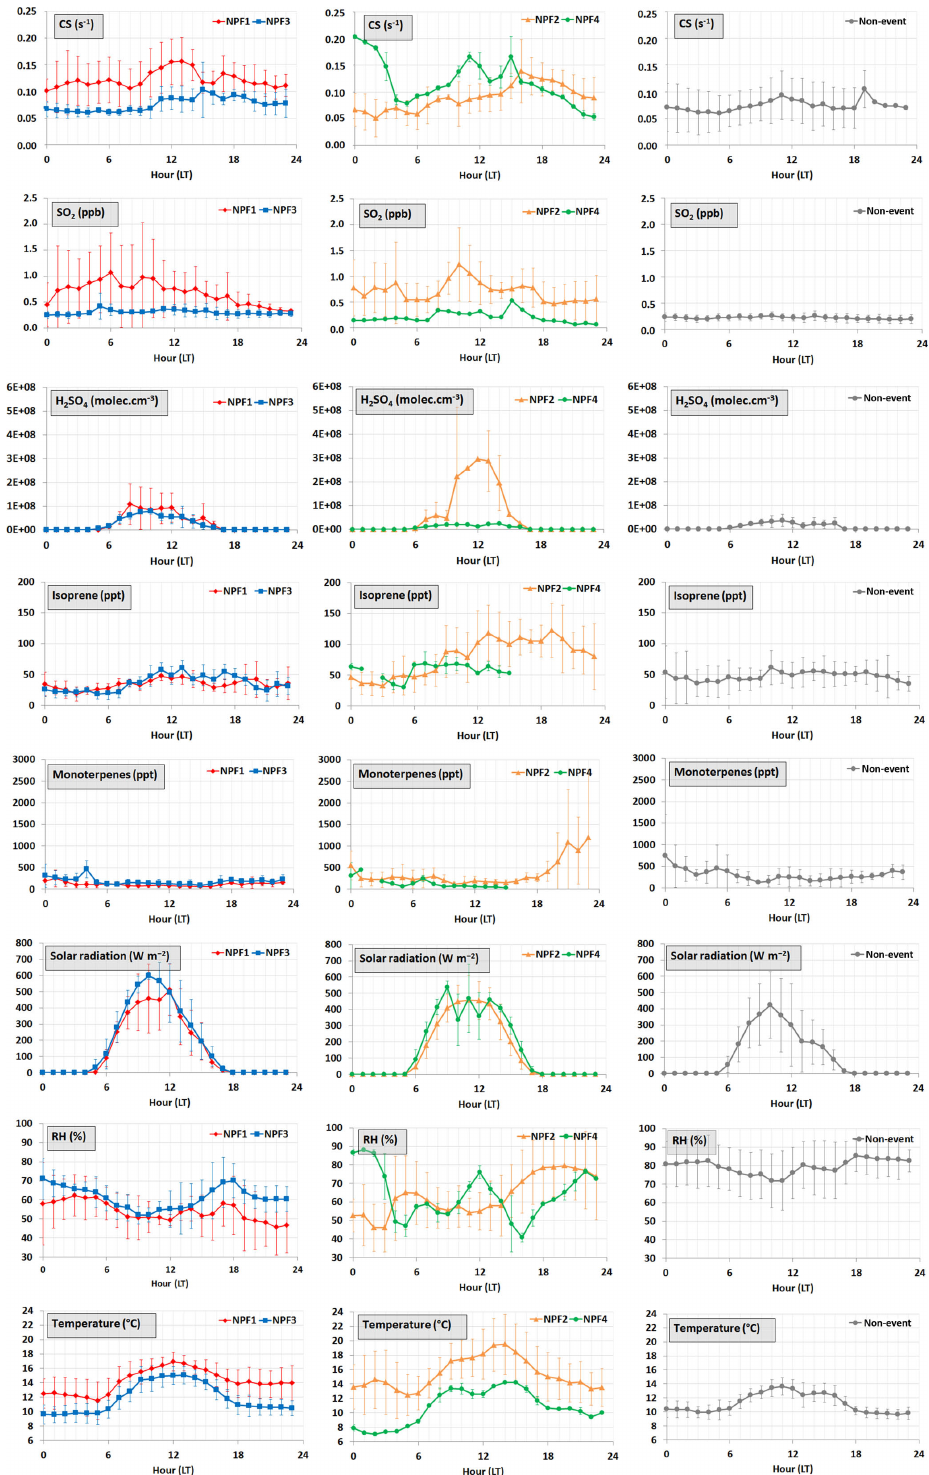
Figure 10. Diel variation of CS, SO 2 , H 2 SO 4 , BVOCs (isoprene and monoterpenes) and meteorological parameters (global solar radiation, relative humidity and temperature) during NPF event days (NPF1–NPF4 displayed as red, yellow, blue and green lines, respectively) and non-event days (grey lines). Diel variations are represented by daily mean values associated with standard deviation when several days were combined. Time is given in local time (UTC +